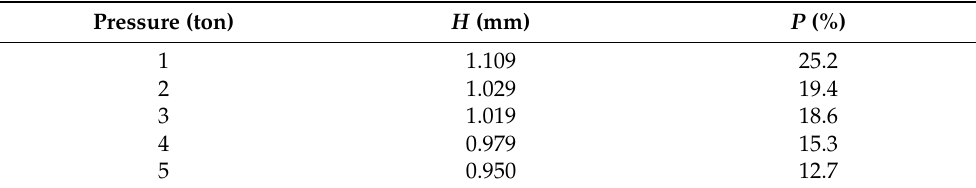
Table 1. Values of the thickness and the porosity of the